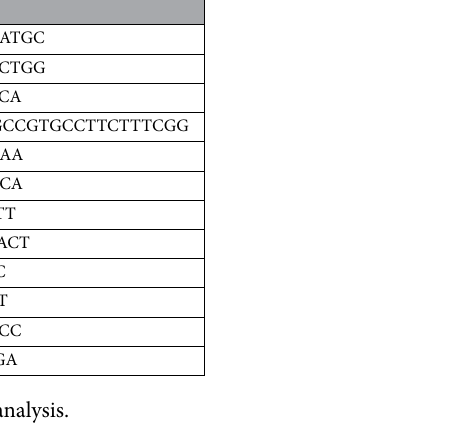
Table 1. Sequences of primers for the qRT-PCR